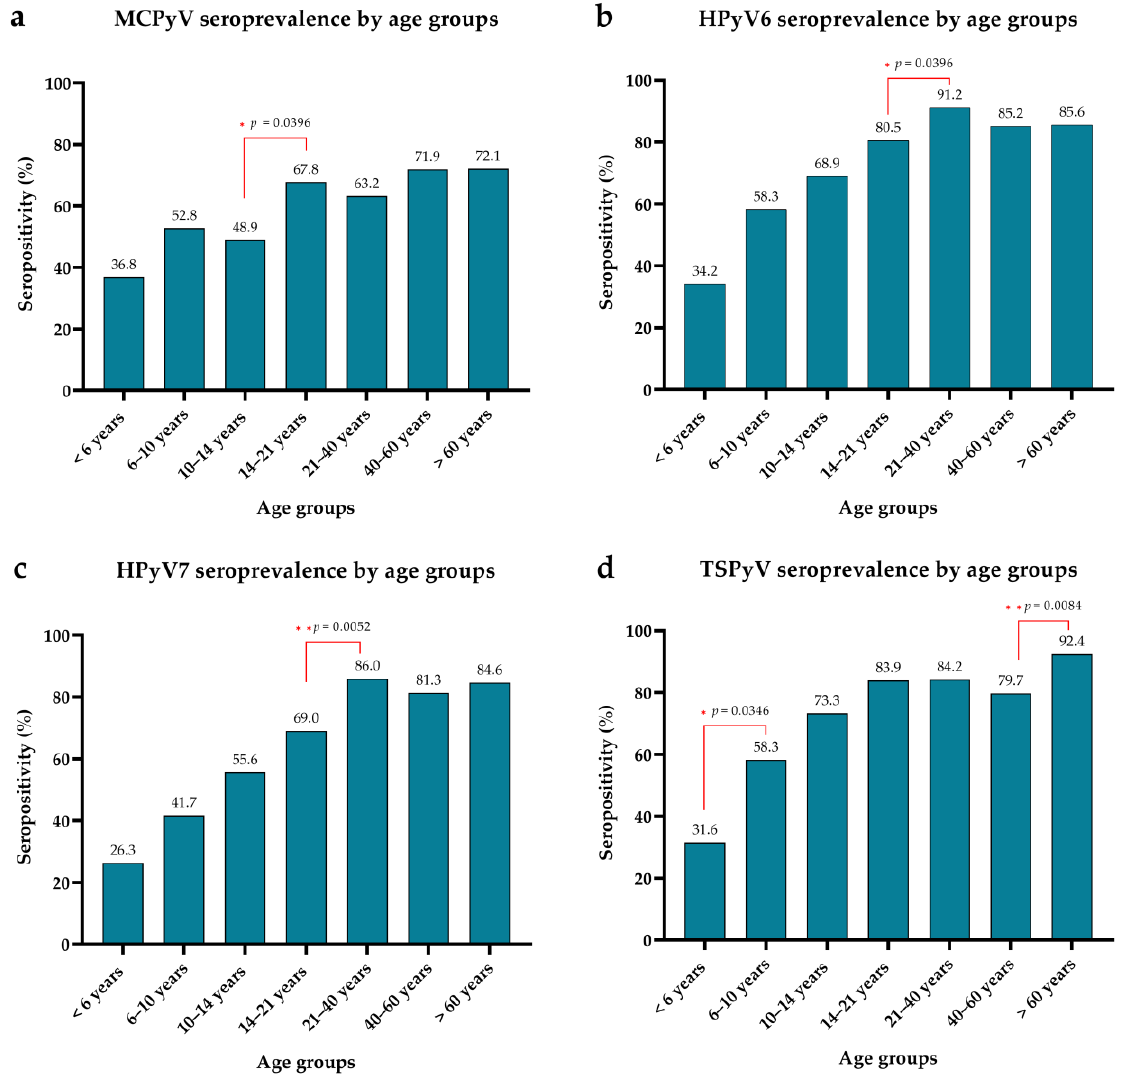
Figure 4. Age-specific seroprevalence of MCPyV ( a ), HPyV6 ( b ), HPyV7 ( c ) and TSPyV ( d ). Signifi- cant differences between age groups are presented with red lines and asterisks (Fisher’s exact test, * p ≤ 0.05, ** p ≤ 0.01).